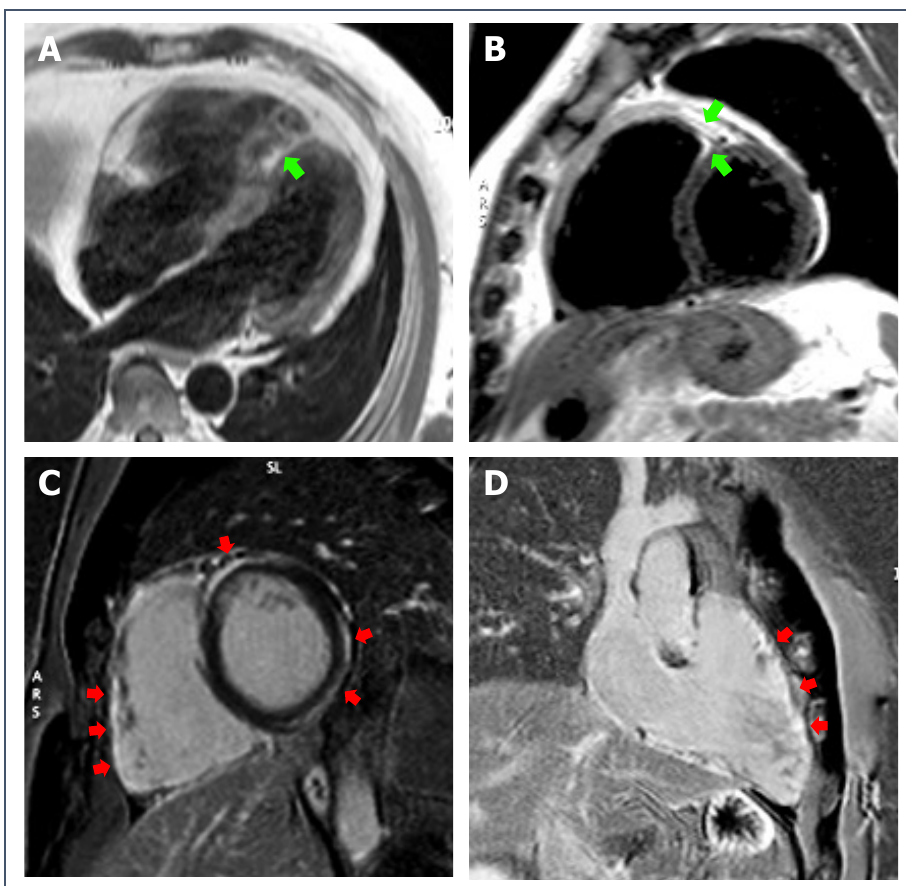
Figure 7. 43-year-old patient with biventricular ACM. T1-weighted sequences ( A ), 4-chambers view, Figure 7. 43 ‐ year ‐ old patient with biventricular ACM. T1 ‐ weighted sequences ( A ), 4 ‐ chambers view, and ( B ), short-axis view) show mild signs of fatty infiltration (green arrows). Post-contrast sequences and ( B ), short ‐ axis view) show mild signs of fatty infiltration (green arrows). Post ‐ contrast se ‐ quences ( C ), short ‐ axis view, and ( D ), right heart 2 ‐ chambers view) reveal non ‐ ischemic LGE in ‐ ( C ), short-axis view, and ( D ), right heart 2-chambers view) reveal non-ischemic LGE involving both volving both RV and LV walls (red arrows). RV and LV walls (red